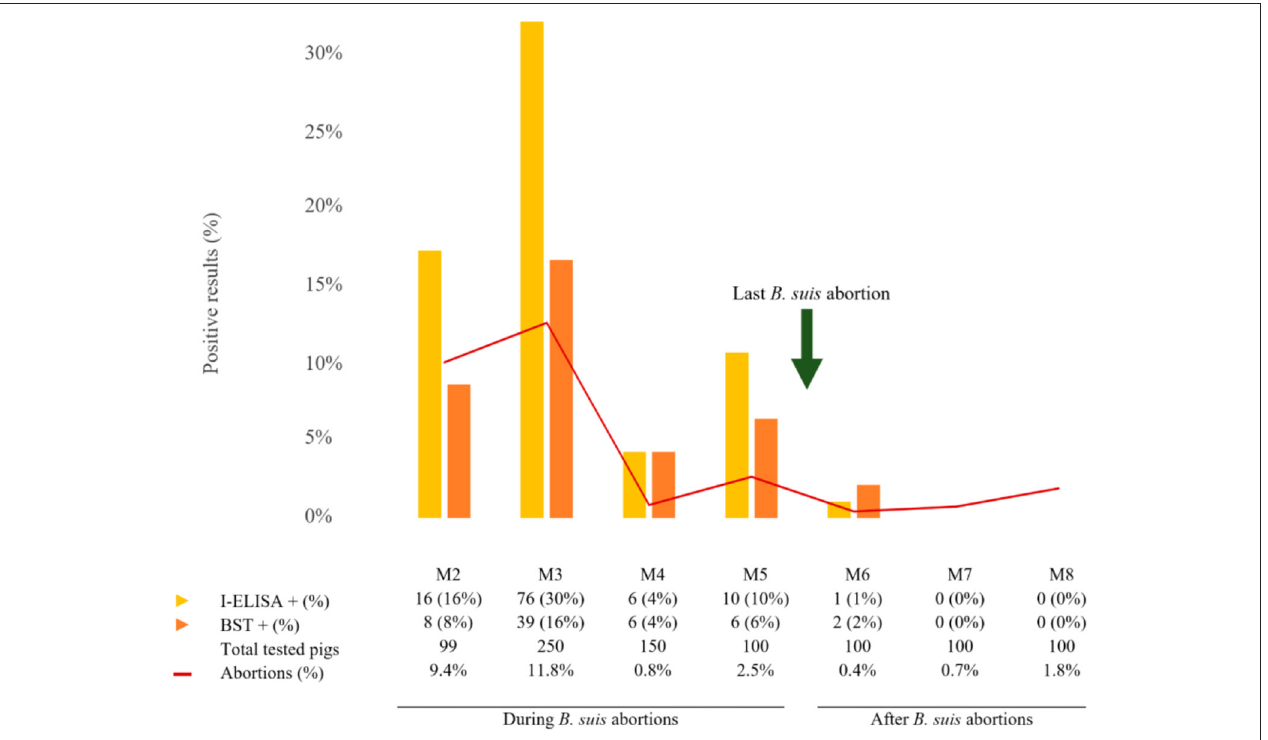
FIGURE 1 | Histogram representing the number of post-weaning pigs, positive or negative to indirect enzyme-linked immunosorbent assay (I-ELISA, yellow) and brucellin skin test (BST, orange), related to total abortions registered in the farm (red line). Results are grouped in pigs born during and after B. suis